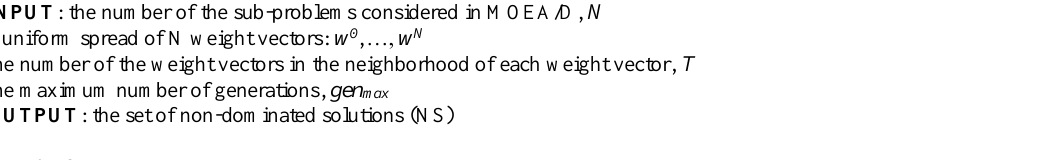
Algorithm 1: The MOEA/D general